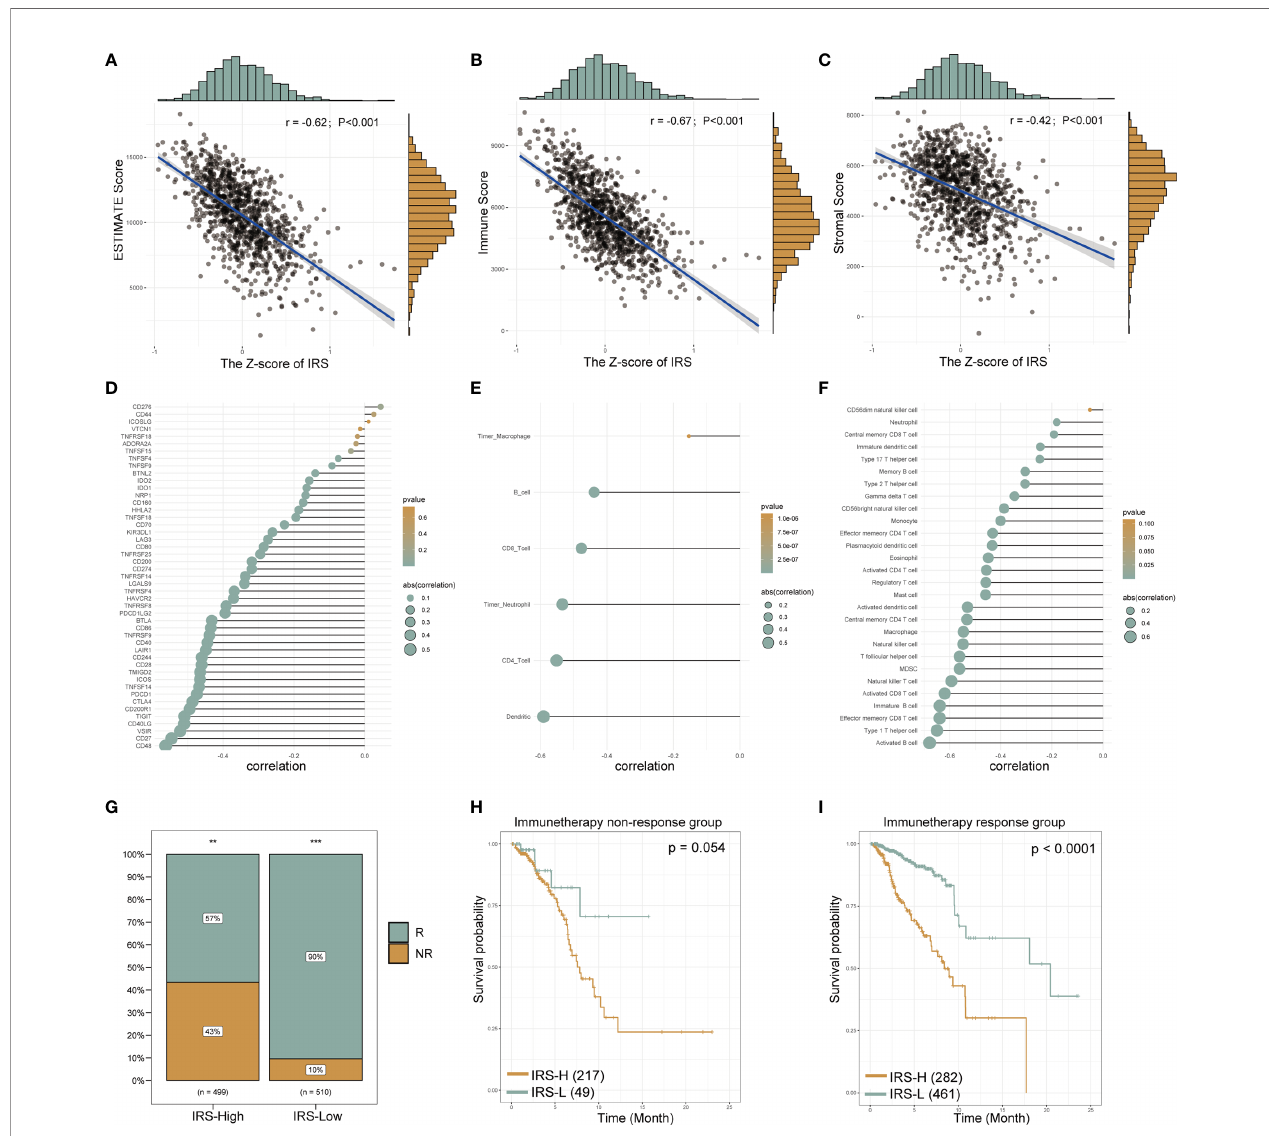
FIGURE 8 | The gene signature serves as a valuable marker for immune targets and immunotherapy response. The estimated scores, immune scores and stromal scores of breast cancer from TCGA database were analyzed by the “ estimate ” R package. The correlation line chart shows the relationship between the Z-score of the IRS and the estimated score (A) , immune score (B) and stromal score (C) (r values and p-values are shown; a larger slope of the line in the graph means a higher correlation) (details see methods section). The correlation bubble chart shows the association between the Z-score of the IRS and immune checkpoint genes (D) , the 6 immune in fi ltration cell scores from TIMER (E) and 28 immune in fi ltration cell scores from TCIA (F) (see the Methods section for data acquisition). The size of the bubble represents the value of the correlation, and the shade of the color represents the value of the p-value. Proportion of immune-responsive and nonimmune-responsive populations in the IRS high- and low-expression groups (G) . Survival analysis graph showing differences in survival between IRS-high and IRS-low groups in nonimmune-responsive (H) and immune-responsive (I) populations. IRS, immune-related risk score; High-IRS, high immune-related risk score; Low-IRS, low immune-related risk score. **means p <0.01, ***means